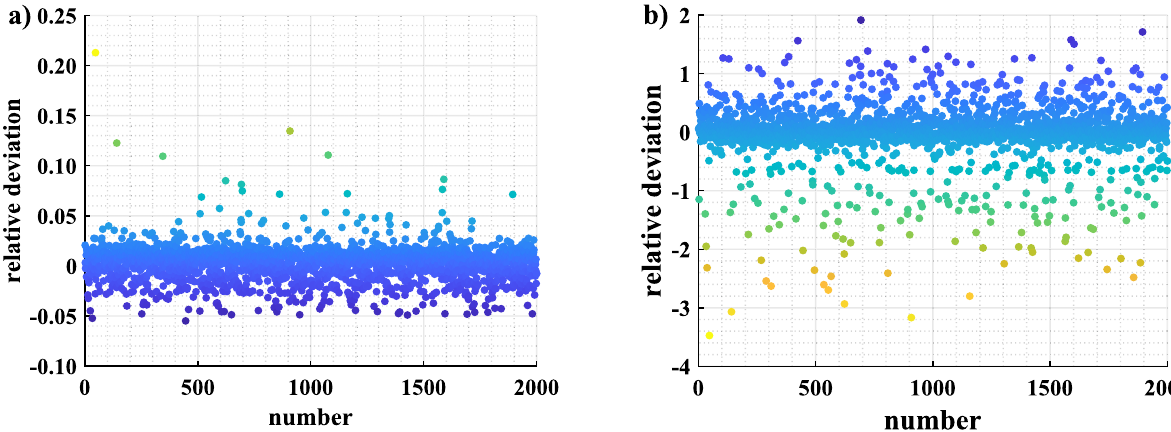
Figure 2. Relative deviations before and after data preprocessing. We use the network structure shown in Fig. 1 with the mean square error as the loss function to compare the results of data preprocessing ( a ) and without data preprocessing ( b ). The data set is generated under the excess noise of 0.002–0.005, and is split into a training set containing 158,000 samples and a test set containing 2000 samples. The horizontal coordinate represents the different samples in the test set. The vertical coordinate represents the relative deviations between the key rate predicted by our neural network and the key rate obtained by the numerical method at each